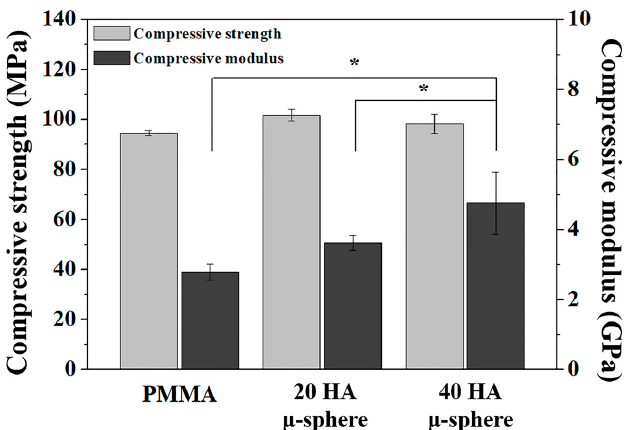
Figure 6. Compressive strengths and compressive modulus of PMMA/HA composites with various HA contents of 20 vol % (20 HA µ-sphere) and 40 vol % (40 HA µ-sphere) and PMMA bone cement containing barium sulfate (PMMA) (* p < 0.05).